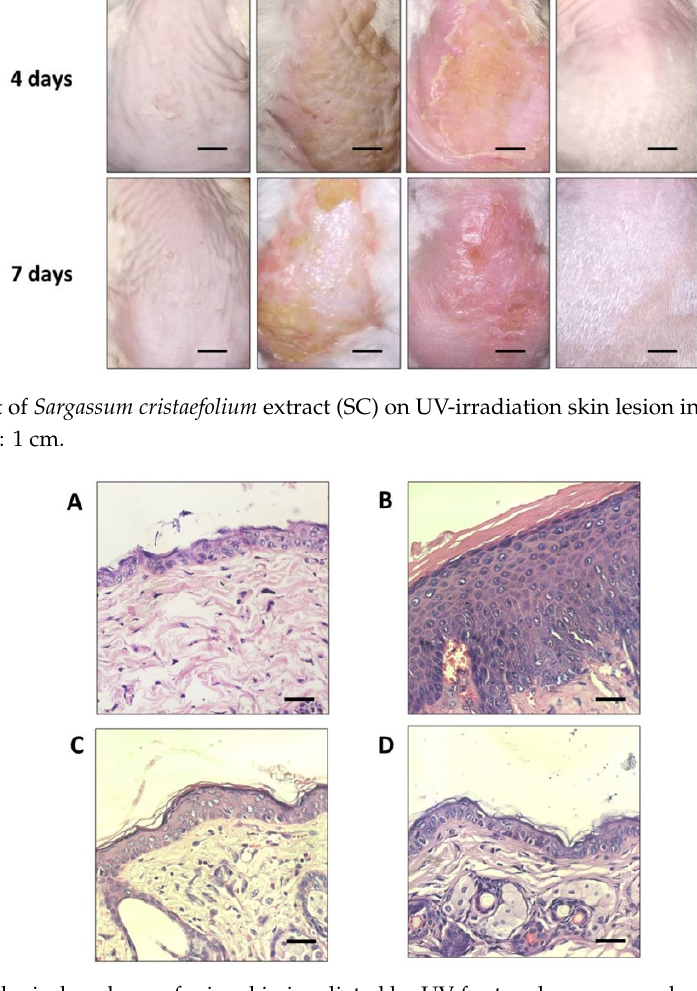
Figure 5. Effect of Sargassum cristaefolium extract (SC) on UV-irradiation skin lesion in mice for seven days. Scale bar: 1 cm.